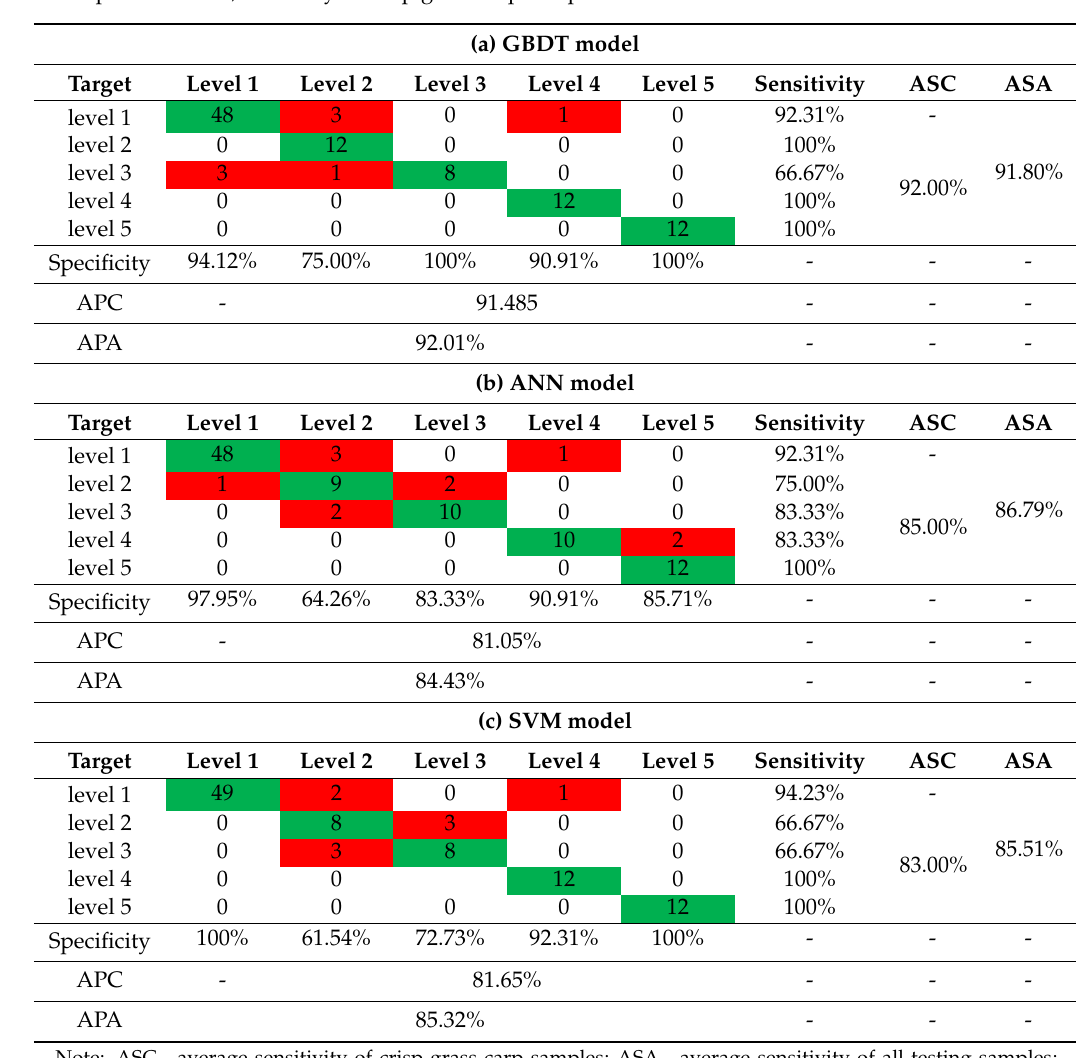
Table 1. Confusion matrix of GBDT, ANN, and SVM classification for crisp grass carp. ( a ) GBDT. Accuracy of all samples = 92.00%; Accuracy of crisp grass carp samples = 91.67%. ( b ) ANN. Accuracy of all samples = 89.00%; Accuracy of crisp grass carp samples = 85.42%. ( c ) SVM. Accuracy of all samples = 91.00%; Accuracy of crisp grass carp samples =